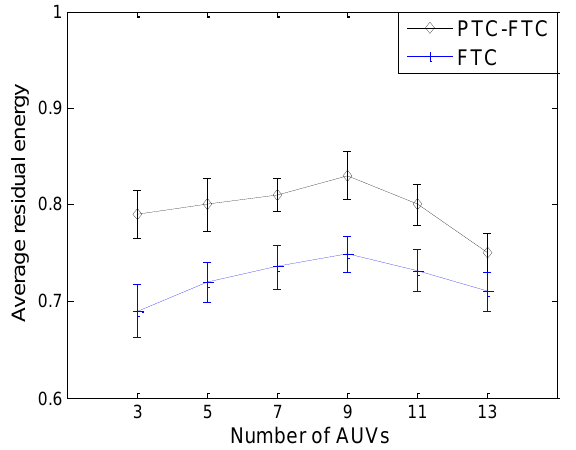
Figure 13. The average residual energy of PTC-FTC and FTC.